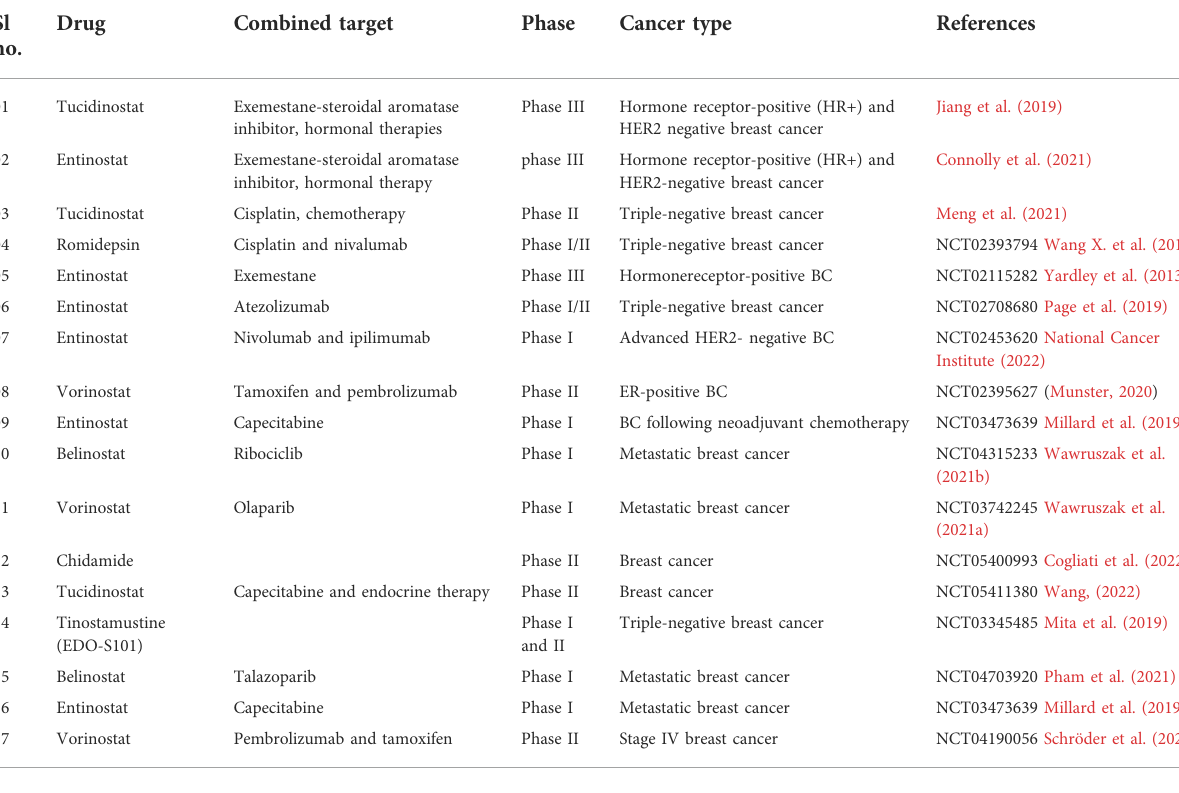
TABLE 6 HDACi in clinical trials of breast cancer. Sl no.